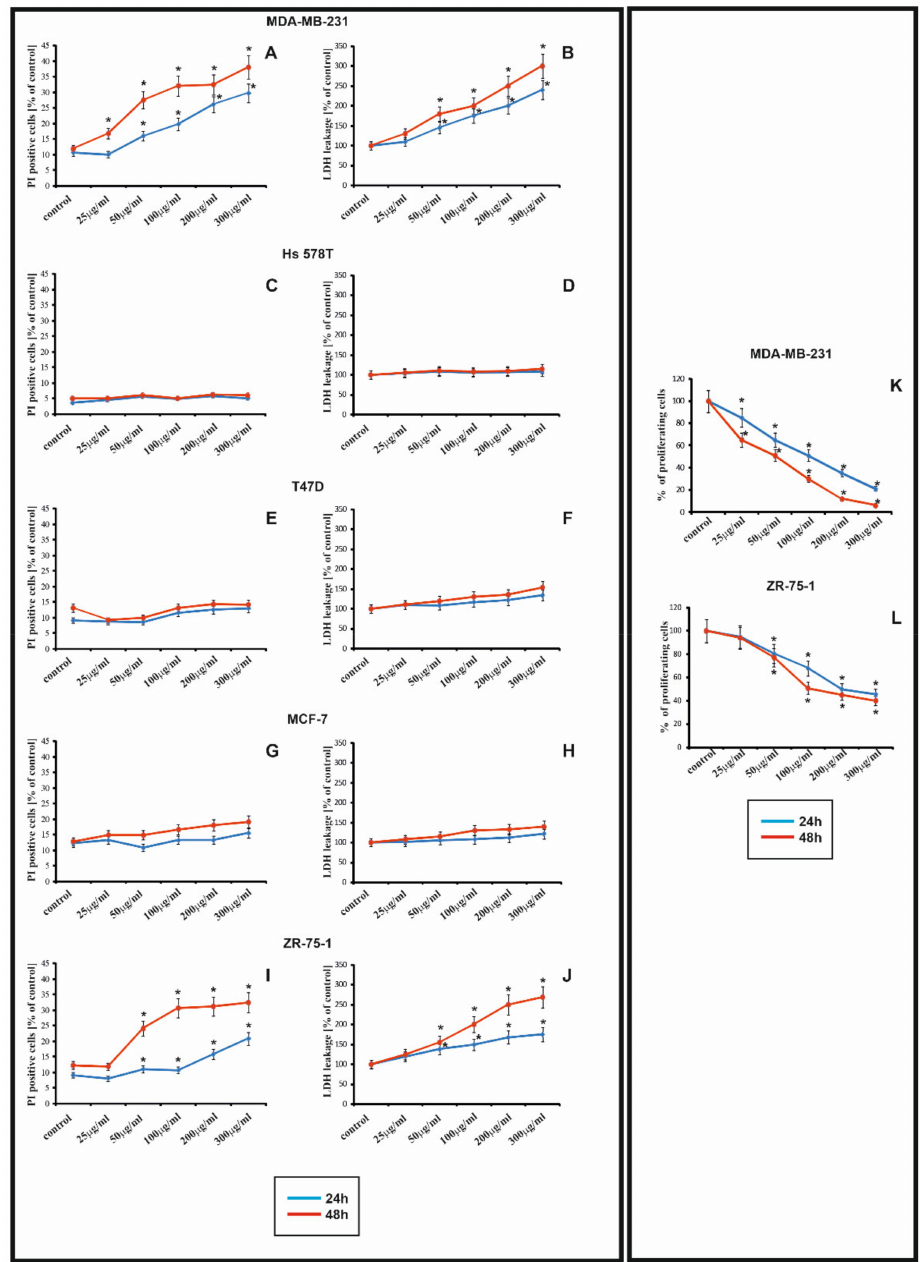
Figure 1. The effect of rGO cytotoxicity and proliferation on T-47D, MCF-7, ZR-75-1, MDA-MB-231, Hs 578T cell lines, was determined using LDH ( B , D , F , H , J ), PI ( A , C , G , E , I ) and crystal violet ( K , L ) test. Viability of MDA-MB-231 ( A , B ), Hs 578T ( C , D ), T-47D ( E , F ), MCF-7 ( G , H ), and ZR-75-1 ( I , J ) cells treated with different concentrations (25 µ g/mL to 300 µ g/mL) of rGO for 24 h (blue lines) and 48 h (red lines). Percentage of LDH leakage or PI uptake was measured by LDH or PI test, respectively. The proliferation analysis of MDA-MB-231 ( K ) and ZR-75-1 ( L ) cells treated with different concentrations (25 µ g/mL to 300 µ g/mL) of rGO for 24 h (blue lines) and 48 h (red lines) using crystal violet assay. The mean values from three independent experiments ± SD are presented. Significant alterations are expressed relative to the controls and marked with asterisks. Statistical significance was considered if * p < 0.05,